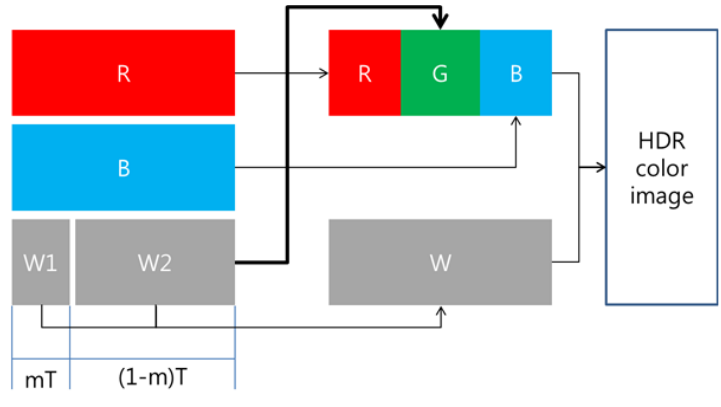
Figure 3. Block diagram of image acquisition system with RWB CFA image sensor. The bold line indicates proposed G channel restoration process. HDR: